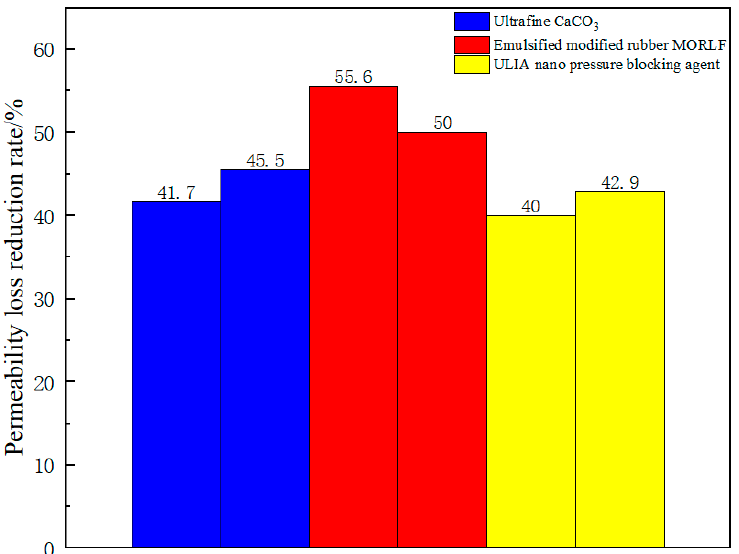
Figure 3. Results of artificial filter cake permeability filtration loss reduction rate test.